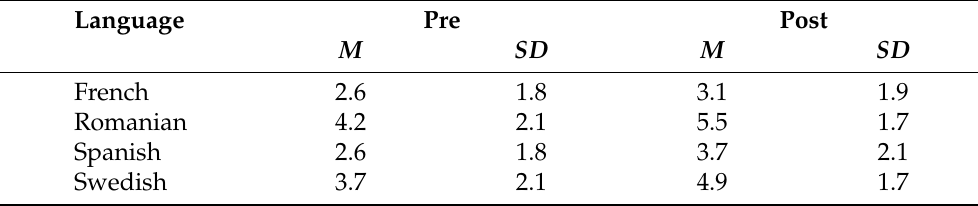
Table A7. I check that the design of images and/or videos have good quality.